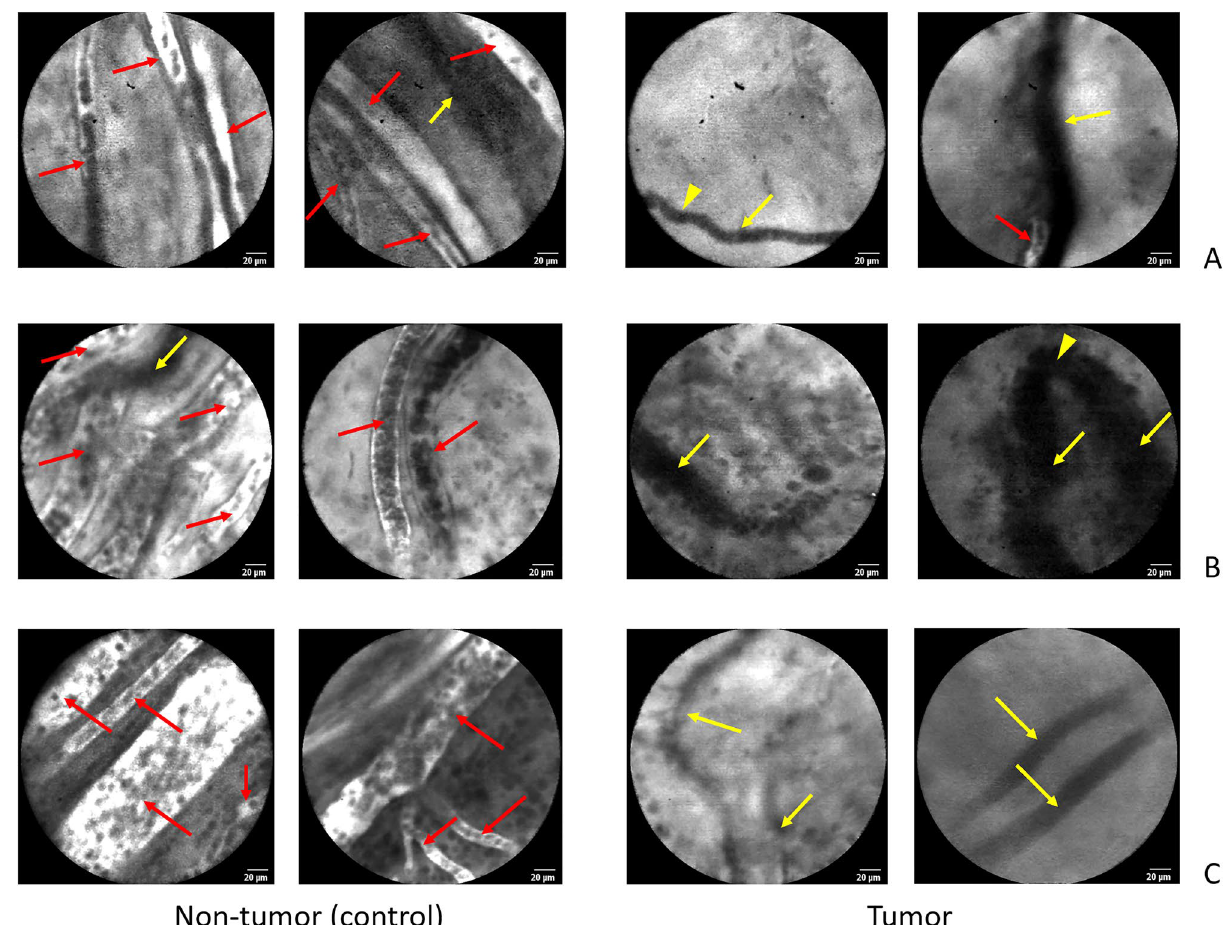
Figure 1. HIVM images of tumor and non-tumor vessels among individual. The right side panel shows examples of PC-associated tumor vessels from different histologies, including appendiceal adenocarcinoma ( A ), ovarian serous carcinoma ( B ), and mesothelioma ( C ). Yellow arrowheads highlight aberrantly arranged PC-associated vessel architecture (such as the acute hair-pin turn in part B), and yellow arrows highlight non- functional vessels as noted by the absence of fluorescein uptake. Non-tumor associated vessels from the same patients in the left side panel show normal, streamlined blood vessels, fewer non-functional vessels, and a higher number of functional (fluorescent) blood vessels. Red arrows highlight functional, normal blood vessels. Non- tumor areas were found to have some non-functional blood vessels, and conversely tumor areas were also found to have some functional blood vessels (red